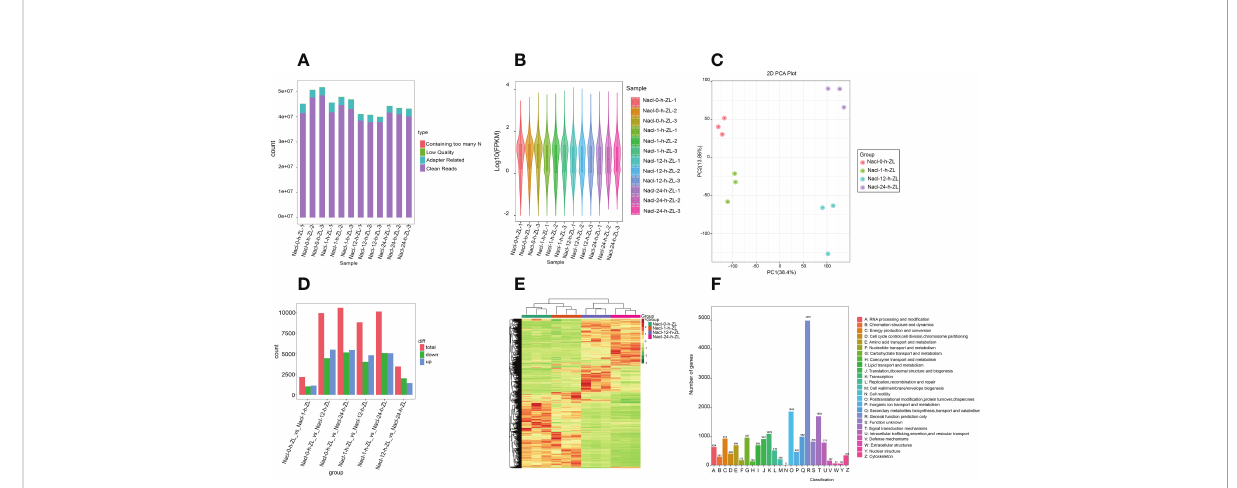
FIGURE 4 Overview of the time course (0 h, 1 h, 12 h, and 24 h) of the S. lycopersicum root transcriptome in response to salt stress. (A) Bar graph of sequencing data and quality control. Following raw data checking, sequencing error rate fi ltering, and GC content distribution screening, clean reads used for follow-up analysis were acquired. (B) Violin diagram of the amount of expression. Various colors in the graph indicate various samples, and the width of each violin graph re fl ects the number of genes at that expression level. (C) The plot of PCA. PC1 indicates the fi rst principal component, PC2 indicates the second principal component, and the percentage represents the explanation rate of that principal component for the data set, each dot in the plot indicates one sample, and samples of the identical set are denoted using the identical color. (D) The statistical plot of DEGs. The red, green, and blue colors represent the total amount of DEGs, the amount of up-regulated DEGs, and the amount of down-regulated DEGs, respectively. (E) Clustering heatmap of DEGs. The horizontal coordinate denotes the sample titles and hierarchical clustering outcomes, and the vertical coordinate denotes the DEGs and hierarchical clustering outcomes. Red denotes high expression and green denotes low expression. (F) Bar graph of KOG classi fi cation. The horizontal coordinate indicates the functional classi fi cation (code) of KOG ID, and the vertical coordinate indicates the number of DEGs included, different classi fi cations are indicated by different colors. The legend shows the code plus its functional description